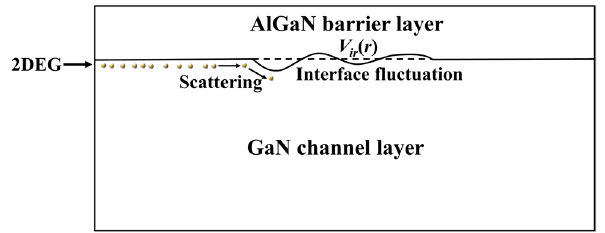
Figure 3. Schematic diagram of interface roughness scattering mechanism. Fluctuation at GaN/AlGaN heterojunction generates a local potential V ir ( r ) and leads to carrier scattering at GaN/AlGaN